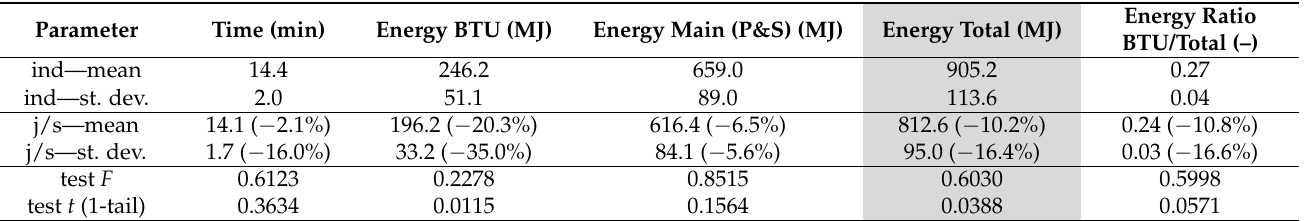
Table 2. Statistical